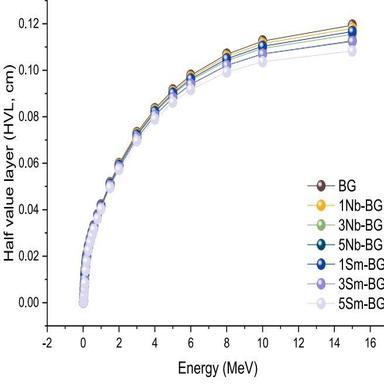
Variation of half value layer (HVL) as a function of increasing energy.